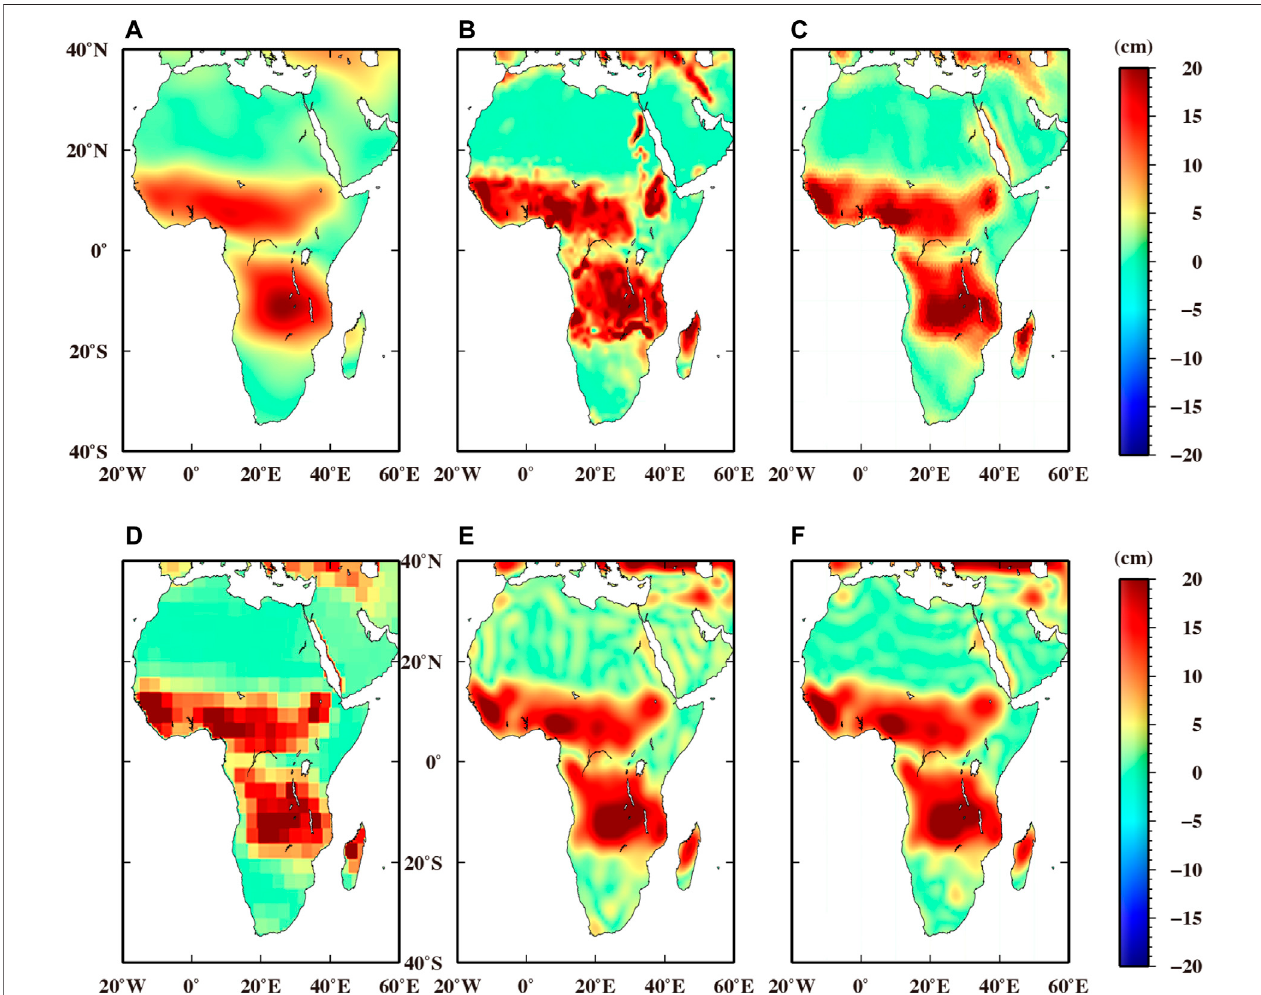
FIGURE 9 | Annual amplitudes (cm) derived from different solutions: (A) CSR Tellus mass grids, (B) CSR Tellus Mass Grid with scale factor, (C) CSR mascon solution, (D) JPL mascon solution, (E) general forward modeling method, (F) improved forward modeling method.